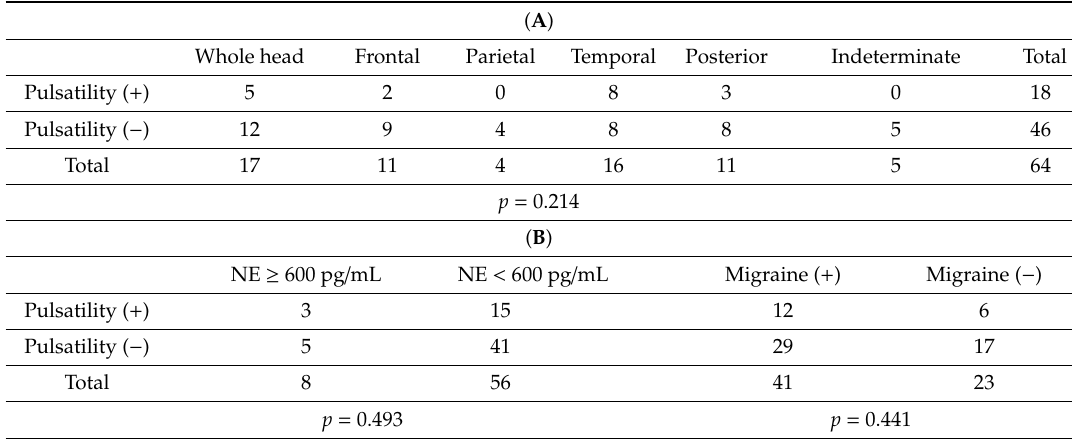
Table 3. Pulsatility of orthostatic